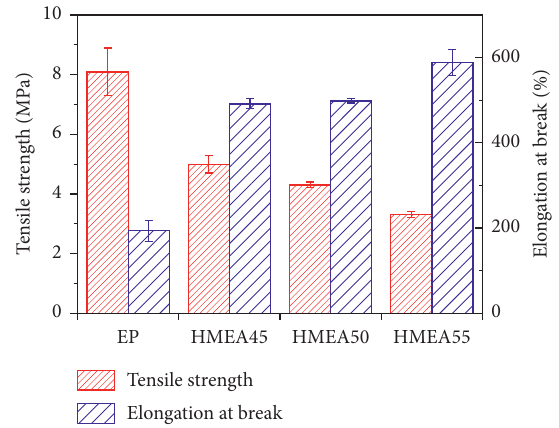
Figure 26: Tensile strength and elongation at break for ER and HMEA [7]. Note: ER � epoxy resin; HMEA � hot-mixed epoxy asphalt; 45, 50, and 55 � asphalt content by weight of HMEA